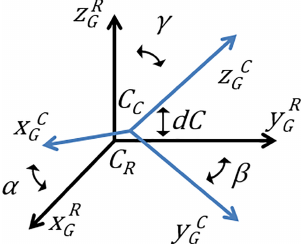
Figure 5. Principle of the comparison between reference and cal- culated gauge coordinate systems.